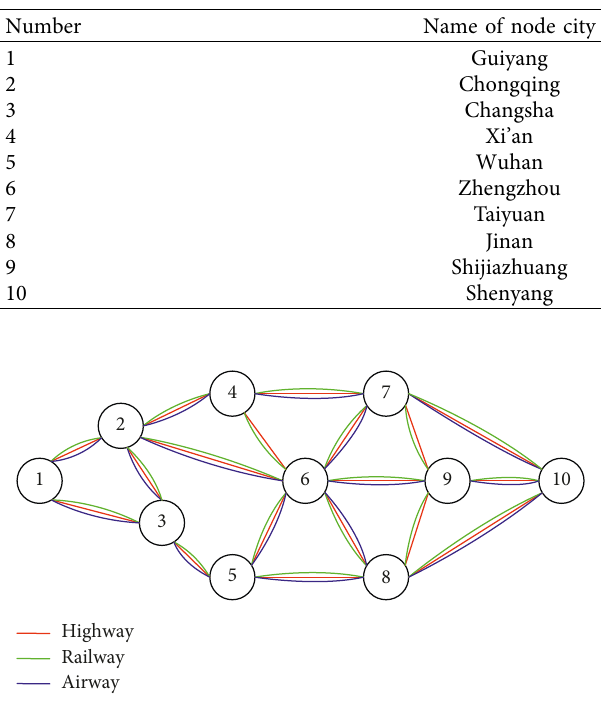
Figure 6: Schematic diagram of multimodal